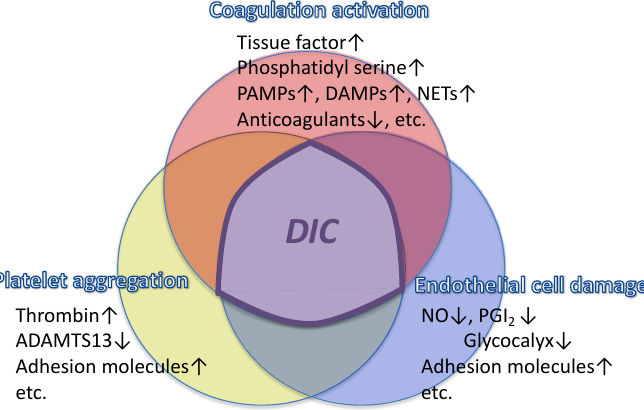
Figure 1. Three major factors contribute to DIC that include coagulation activation, platelet aggregation, and endothelial damage. Tissue factor expressed on the leukocytes and phosphatidylserine on the damaged cell membrane activate coagulation, decreased physiologic anticoagulant systems accelerate clot formation, and platelet aggregation is stimulated by thrombin and other inflammatory mediators. Endothelial damage reduces the antithrombotic milieu of the vascular lumen. PAMPs: pathogen-associated molecular patterns, NETs: neutrophil extracellular traps,